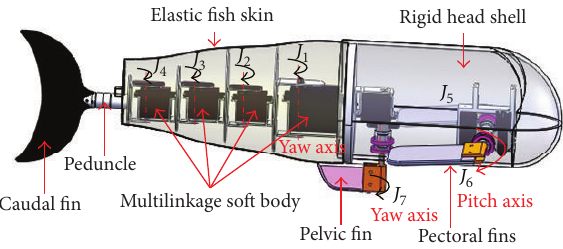
Figure 1: Mechanical drawing of a self-propelled robotic fish with multiple control